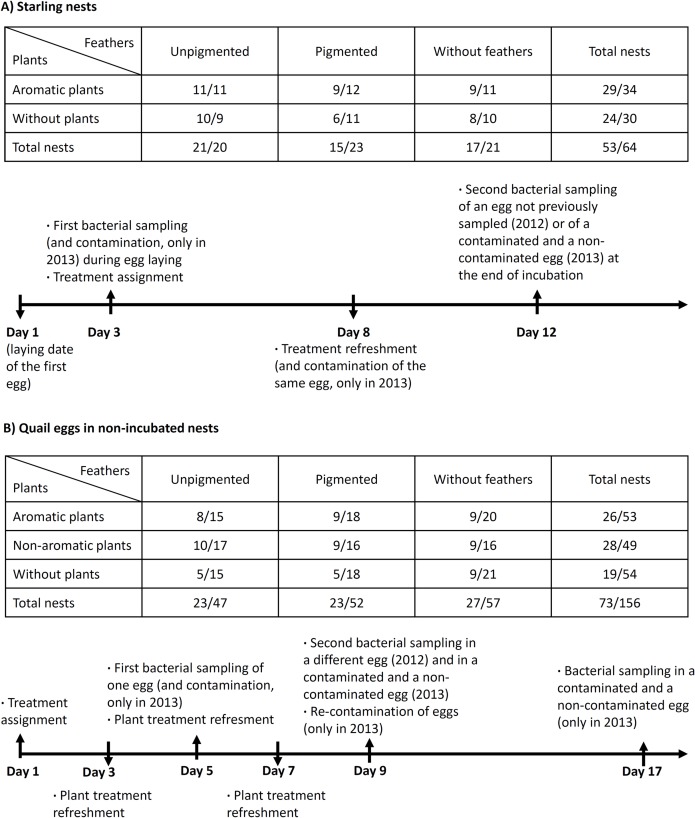
Experimental design of artificial and natural nests.Experimental protocols designed for exploring the effects of feathers and aromatic plants as nest materials on bacterial loads on spotless starling eggs (A) and on quail eggs in non-incubated nests (B). Numbers within the tables indicate sample sizes of different experimental treatment for 2012/2013 study years.